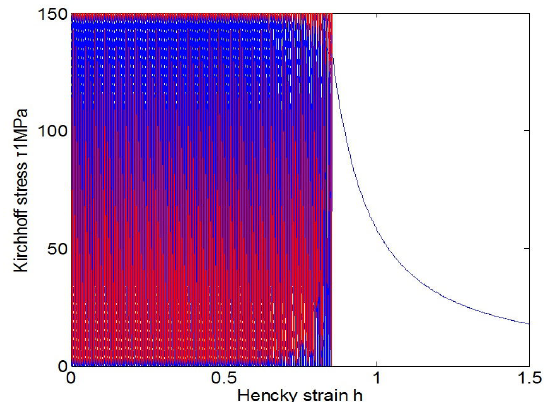
Figure 5. Ratcheting response of the new model with the plastic indicator Equation (16) under uniaxial stress cycling from 0 to 150 MPa and then back to 0, in which a critical failure state is reached at the number of 40,746 cycles.